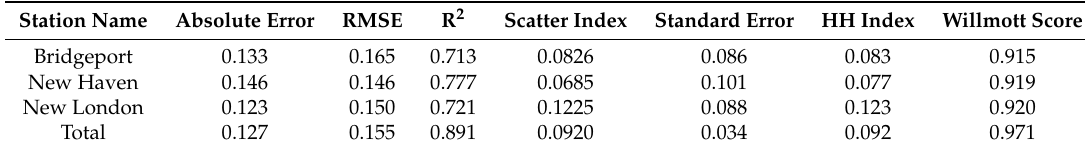
Table 4. Error metrics of the modeled and observed water levels.